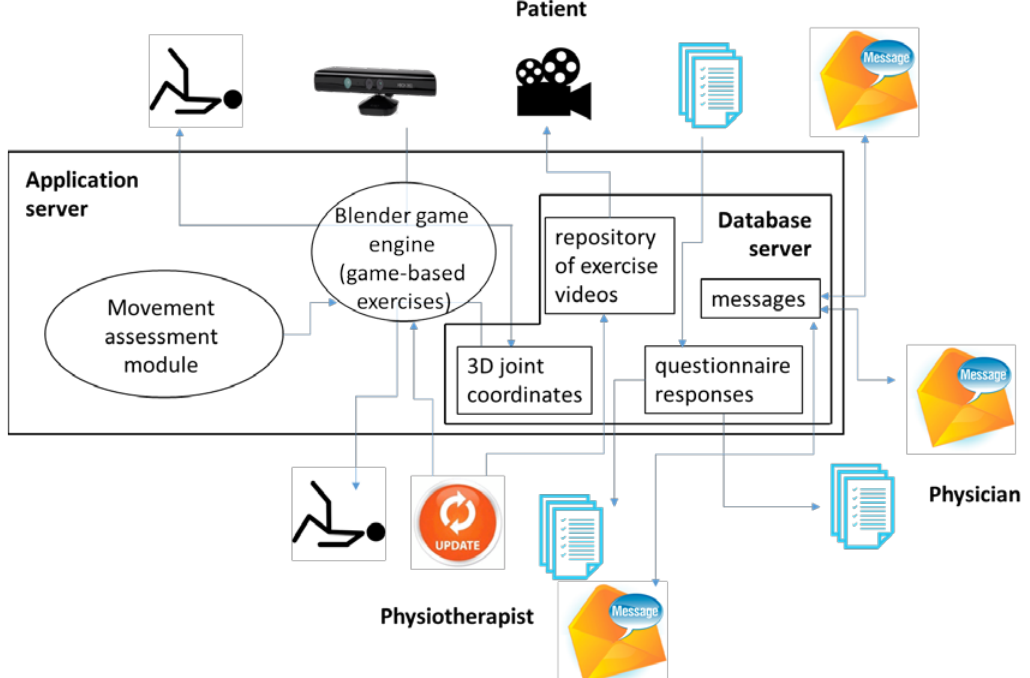
Figure 1 | Architecture of the tele-rehabilitation